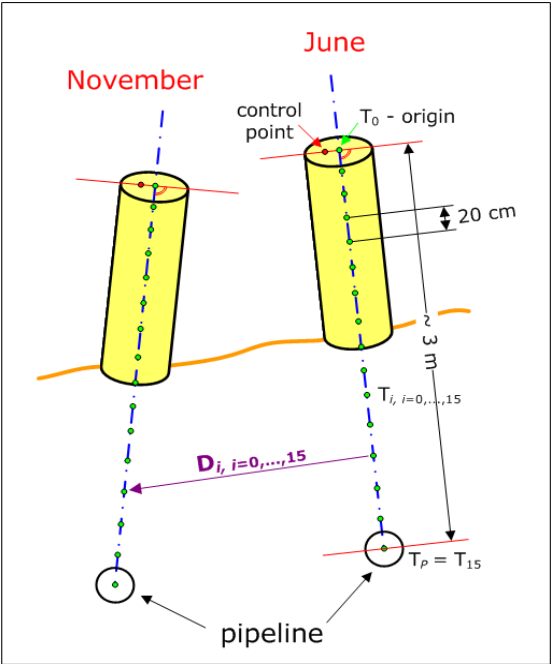
Figure 10. Identical points for the determination of displacements D T and the point in the centre of the pipeline T 0